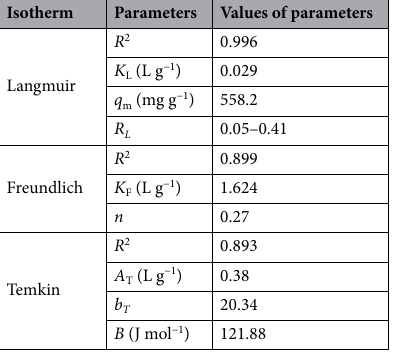
Isotherm Parameters Values of